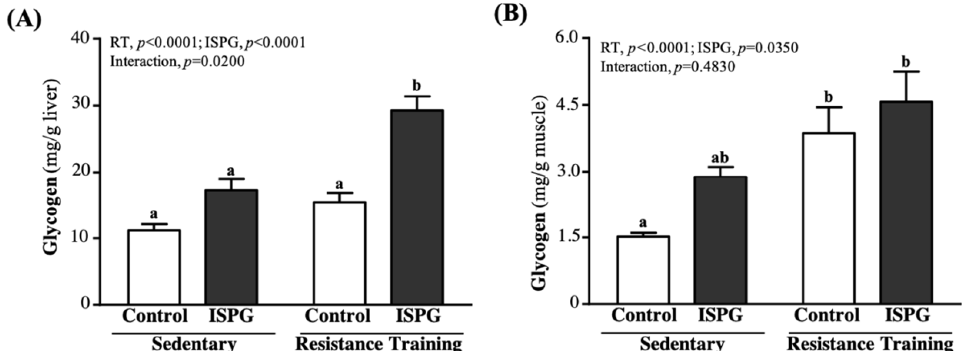
Figure 7. Effect of ISPG and resistance training on ( A ) hepatic and ( B ) muscle glycogen level. Data are expressed as the mean ± SEM of 8 mice/group. Different superscript letters (a, b) above the bar are significantly different at p < 0.05. If any letter is the same, it means that the difference between groups is not significant.